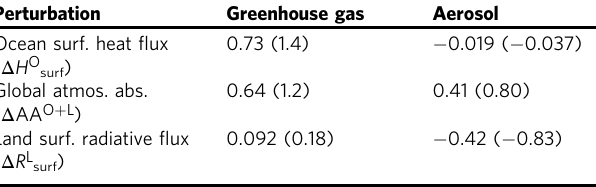
Table 1 Annual mean energy balance perturbations Perturbation Greenhouse